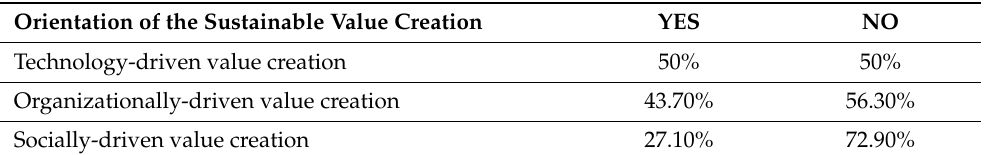
Table 2. Orientation or drivers of the sustainable value creation of respondents, percentage of respondents’ answers ( n = 48) (source: authors’